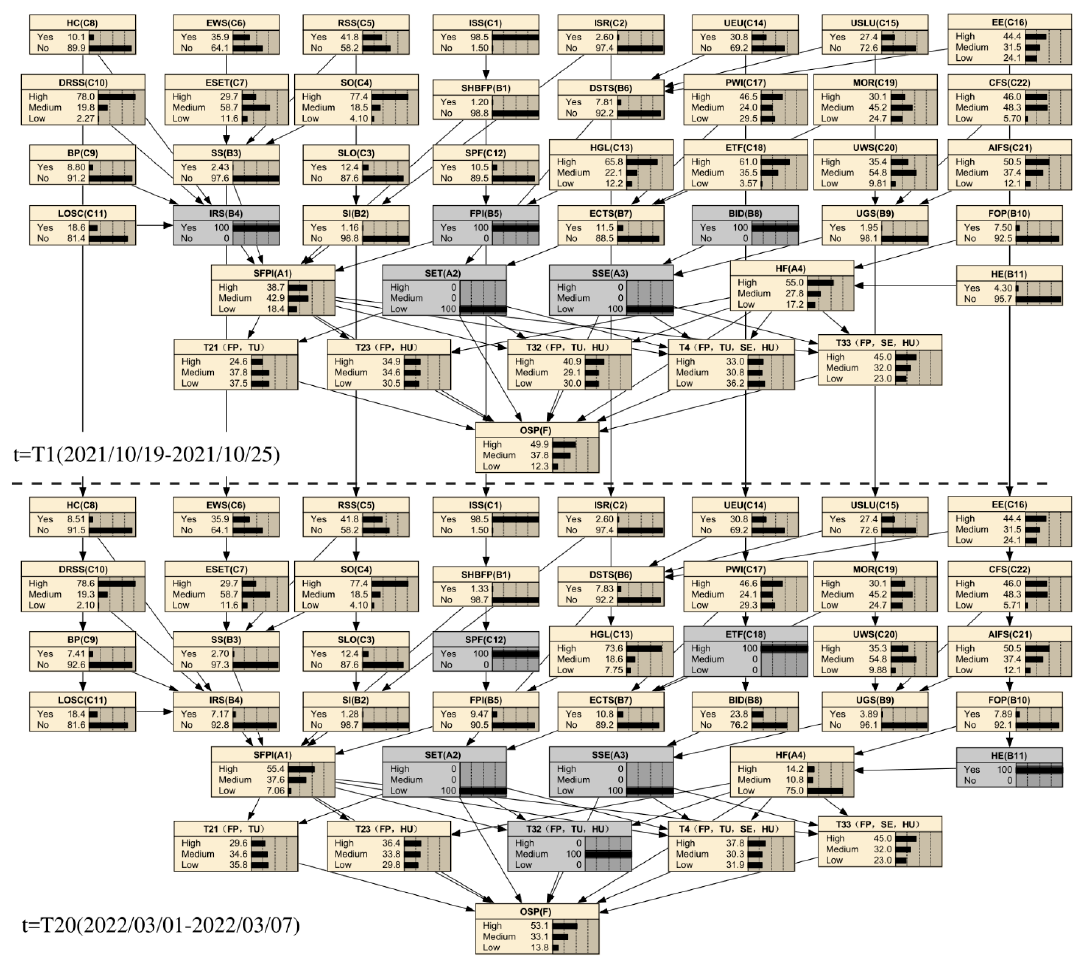
Figure 14. Two scenarios of dynamic Bayesian network modeling for forward inference (T1 and T20).